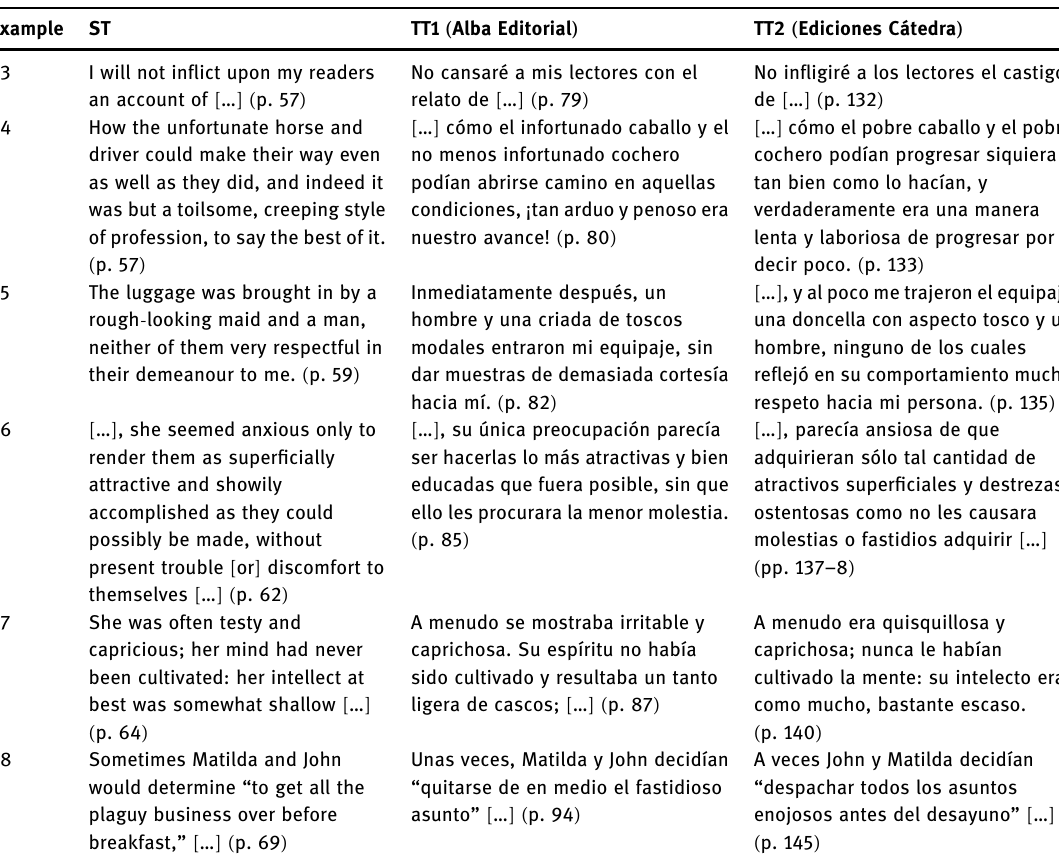
Table 7: Examples taken from Chapter 7 Example